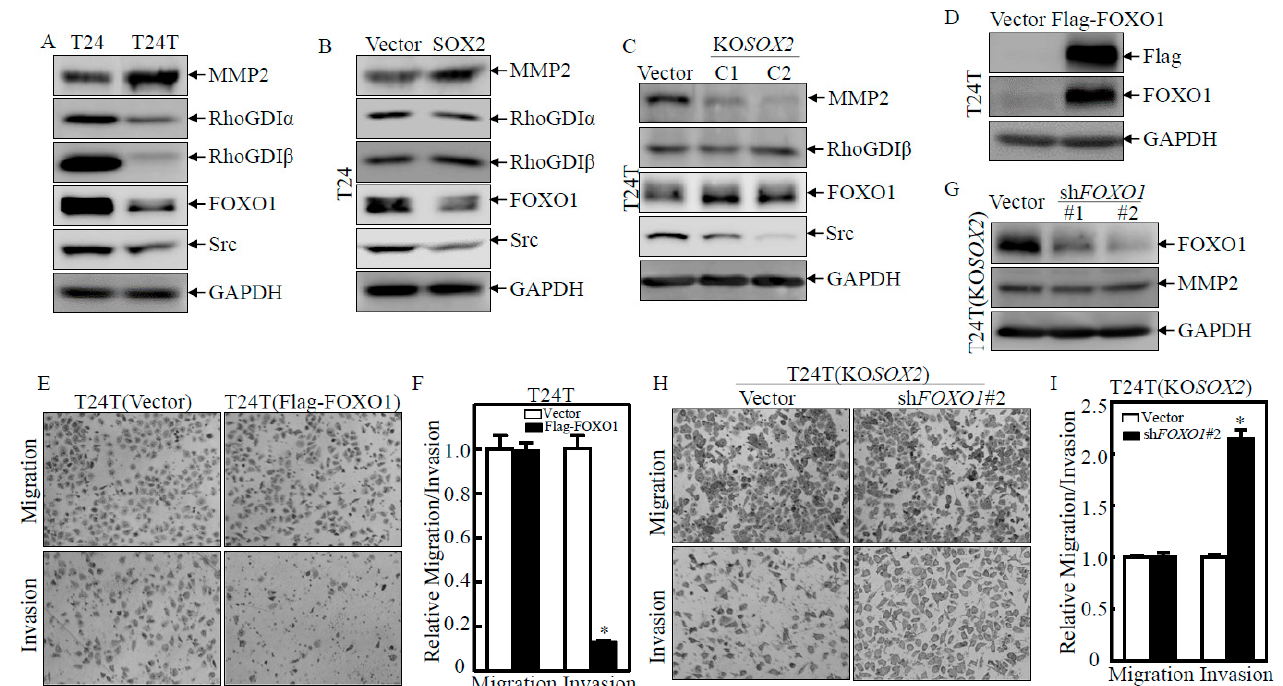
Figure 2. Upregulation of MMP2 and downregulation of FOXO1 play a crucial role in the invasive ability of BC cells. ( A – D , G ) The indicated cells were seeded into six-well plates. The cells were extracted upon the cell density reaching 80–90%, and the cell extracts were subjected to Western blot for the determination of protein expression as indicated. GAPDH or β -Actin was used as a protein-loading control. ( E , F , H , I ) The invasion abilities of the T24T(Vector) versus T24T(Flag-FOXO1) cells and T24T(KO SOX2 /Vector) versus T24T(KO SOX2 /sh FOXO1 #2) were determined using a BD BioCoat TM Matrigel TM Invasion Chamber. The asterisk (*) indicates a significant difference in invasion abilities in comparison to their corresponding vector control transfectants ( p < 0.05). The bars are presented as the mean ± SD from three independent experiments.